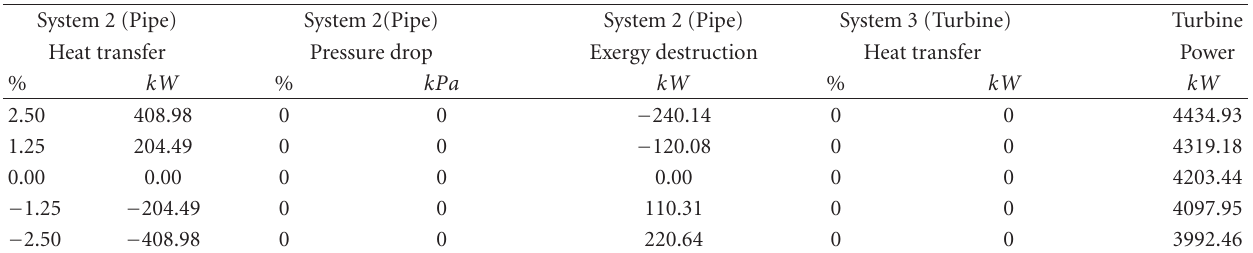
Table 5: Numerical results for 1 DOF exergy-based